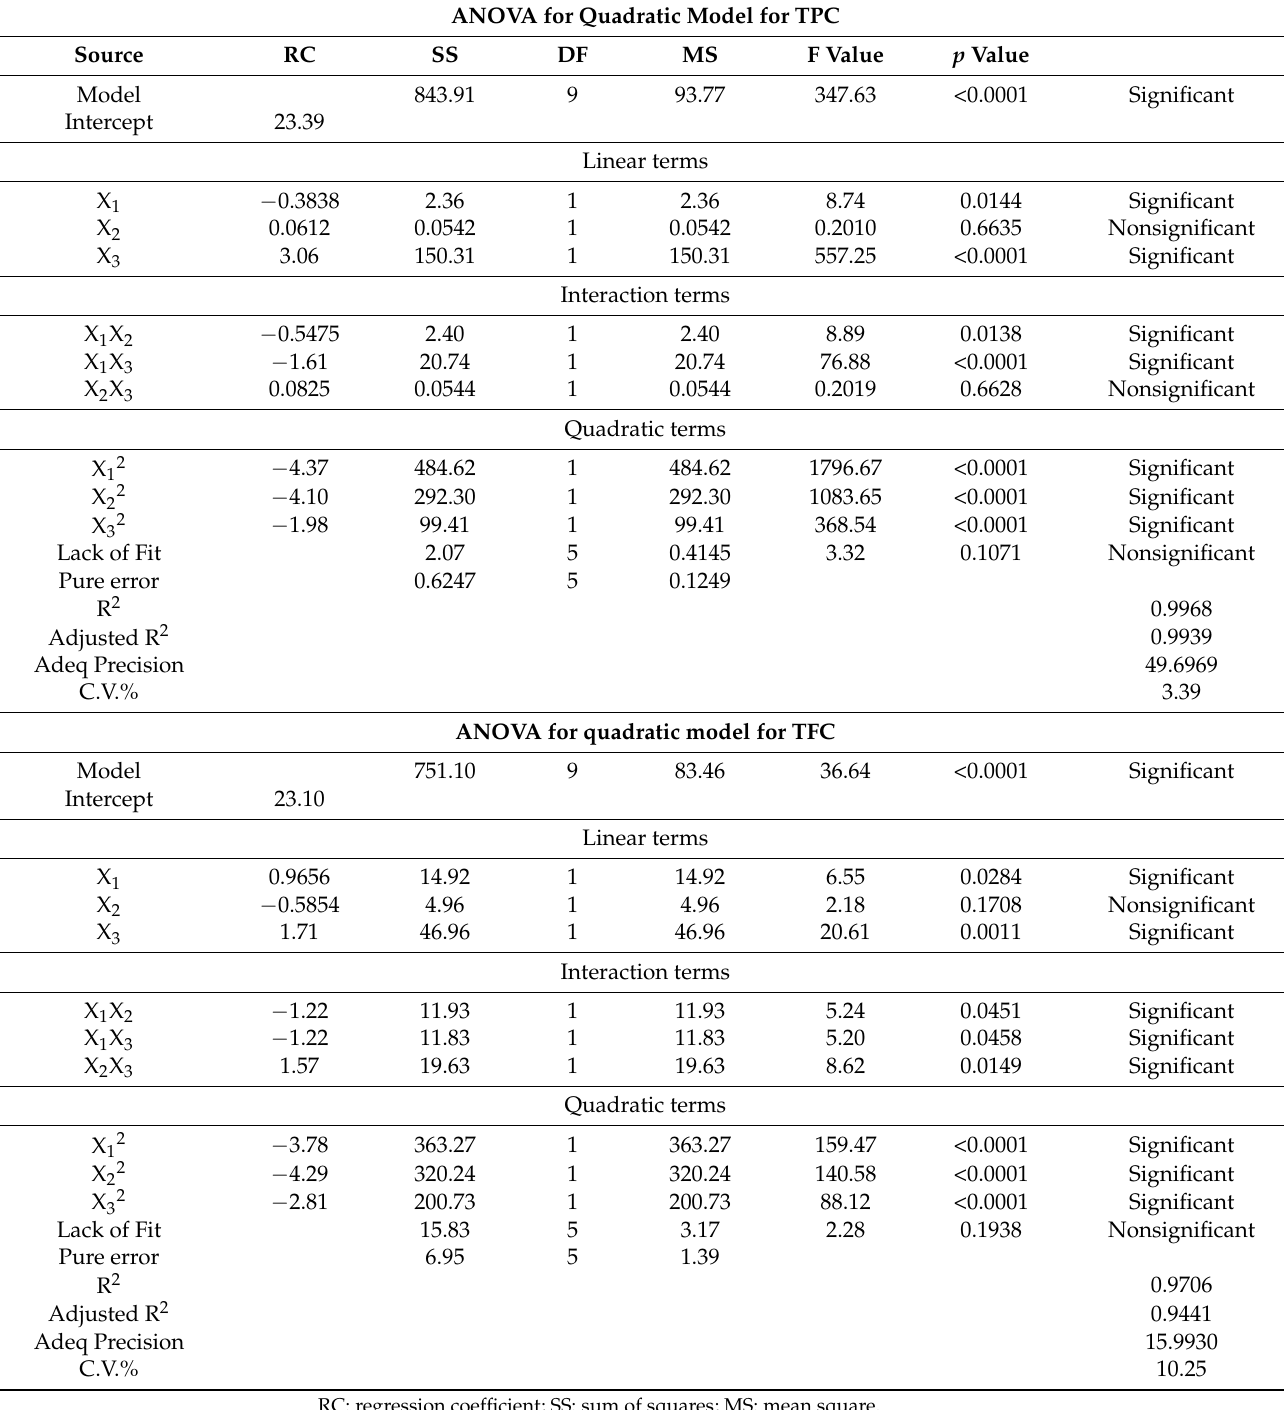
Table 2. ANOVA for quadratic